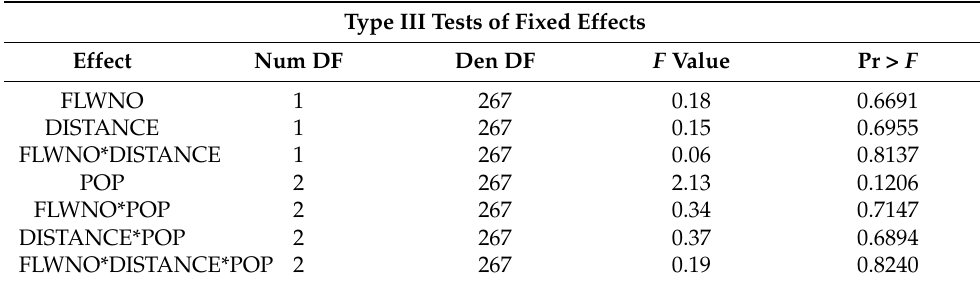
Table A17. The effect of maximum flower number and interplant distance on fruit set in the three- population study in 2019.